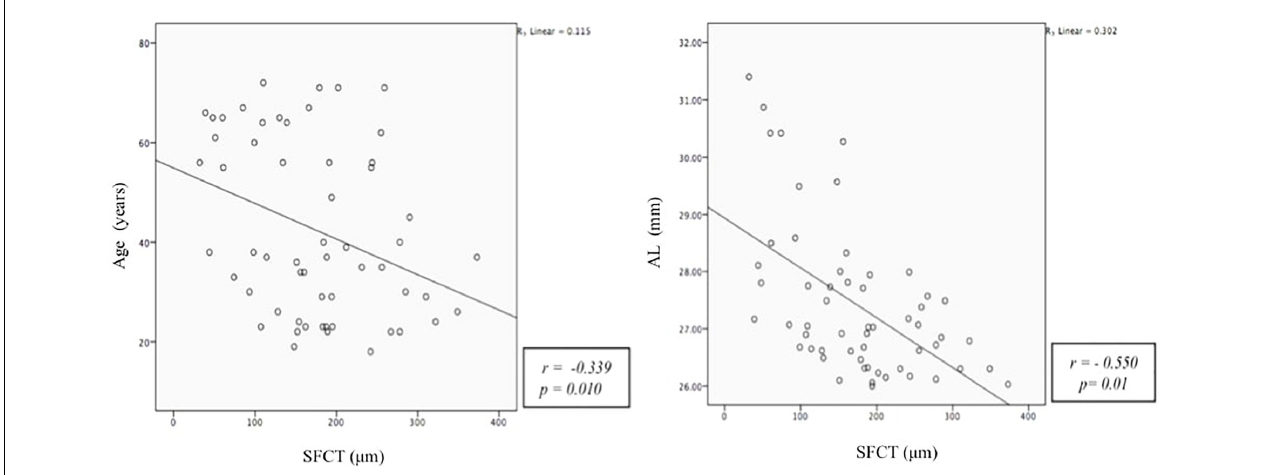
FIGURE 2 | Scatter plot demonstrating the correlation between subfoveal choroidal thickness (SFCT, mm) with age (years) and axial length (AXL, mm). The Y-axis does not begin at zero.